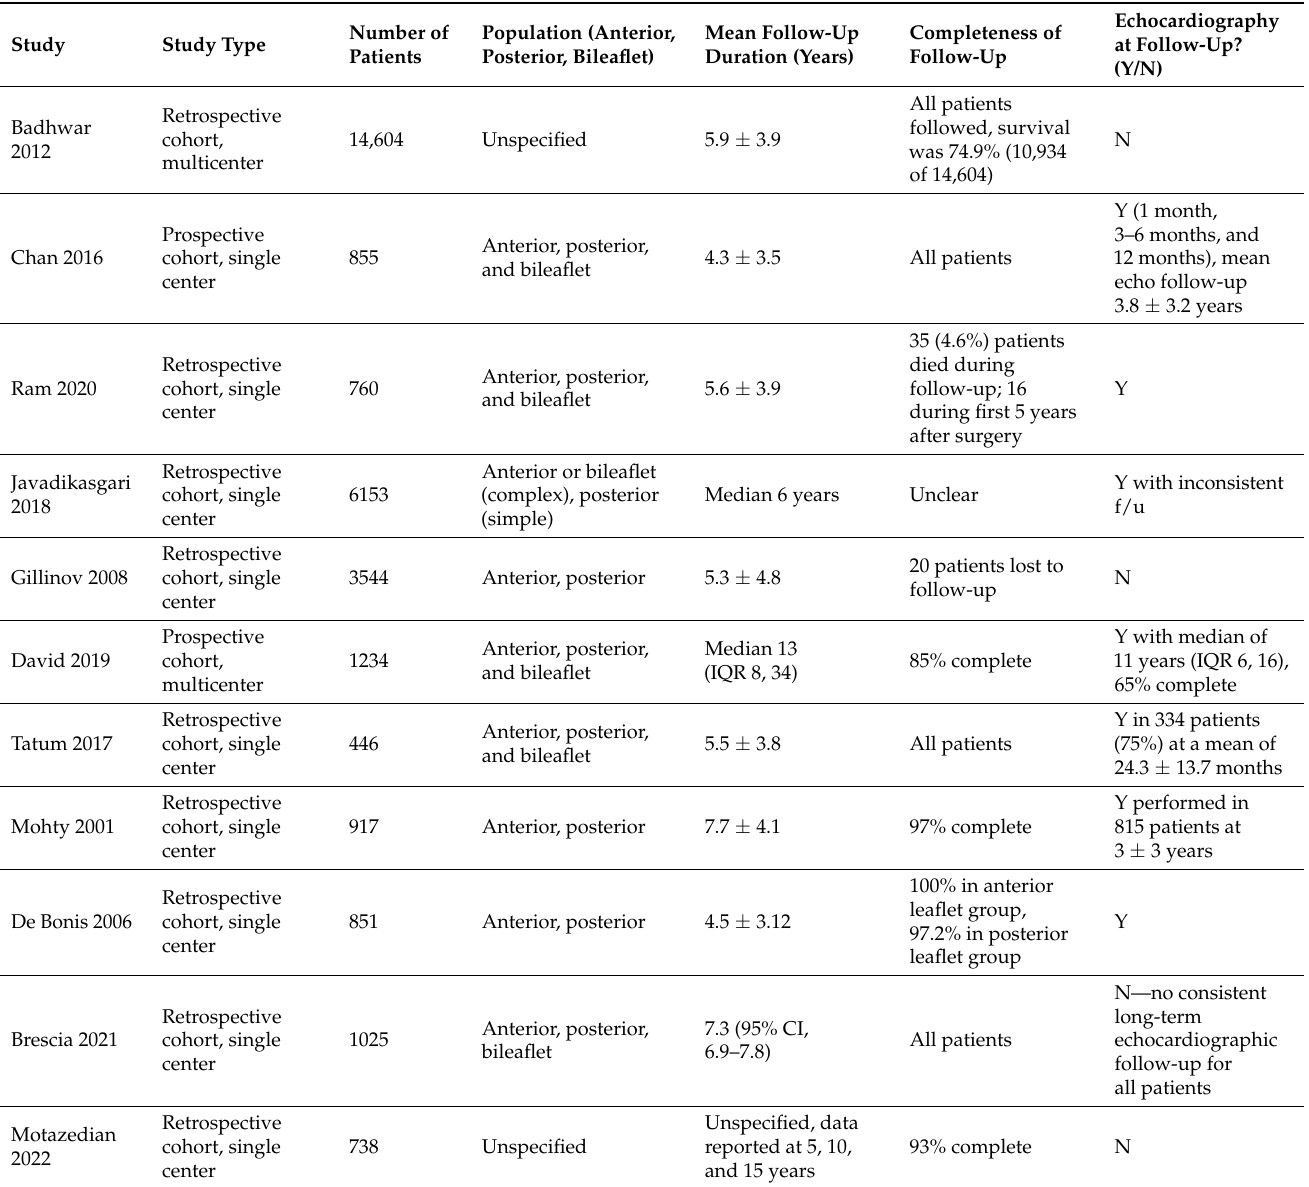
Table 1. Summary of studies evaluating longitudinal outcomes of patients undergoing mitral valve repair for degenerative mitral regurgitation and associated